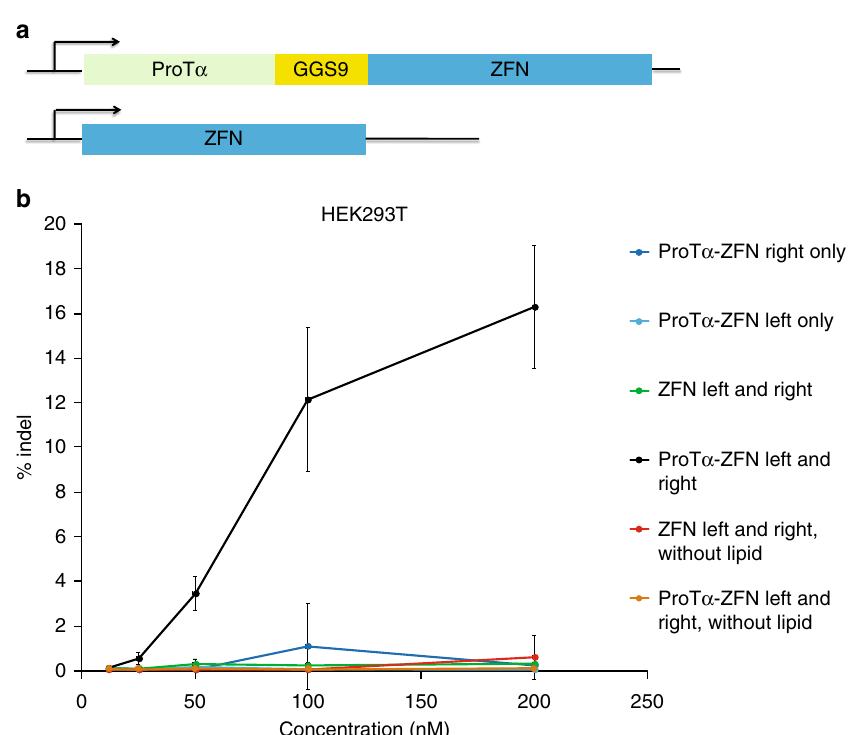
Fig. 5 Delivery of zinc- fi nger nucleases (ZFNs) using ProT α . a Structure of ProT α -fused ZFN versus ZFN alone. b ProT α -fused ZFNs or unfused ZFNs targeting the AAVS1 site in HEK293T cells were delivered using Lipofectamine RNAiMAX. ProT α enables ef fi cient delivery of ZFNs and induce indels at a mid-nanomolar concentrations. Both left and right ZFN components, as well as lipid, are required for ef fi cient indel generation. Values and error bars represent the mean and standard deviation of three independent biological replicates performed on different days. Source data are available in the Source Data fi